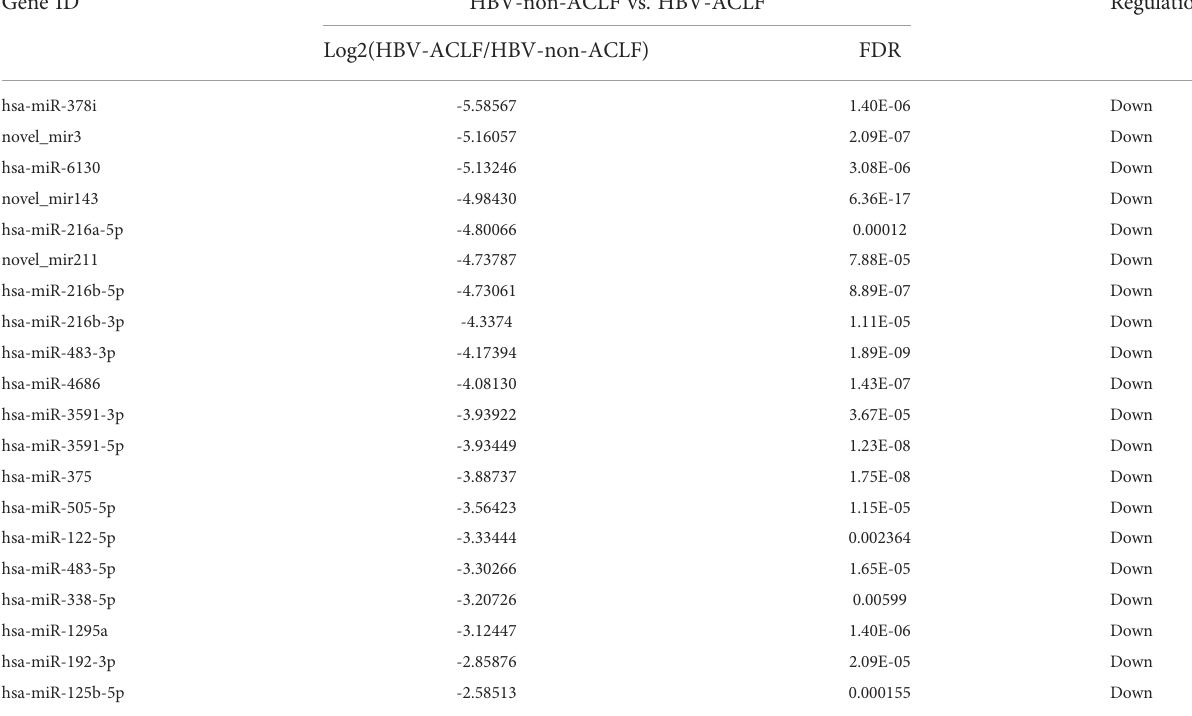
TABLE 3 Twenty of the downregulated DE-miRNAs in the HBV-ACLF group compared to the HBV-non-ACLF